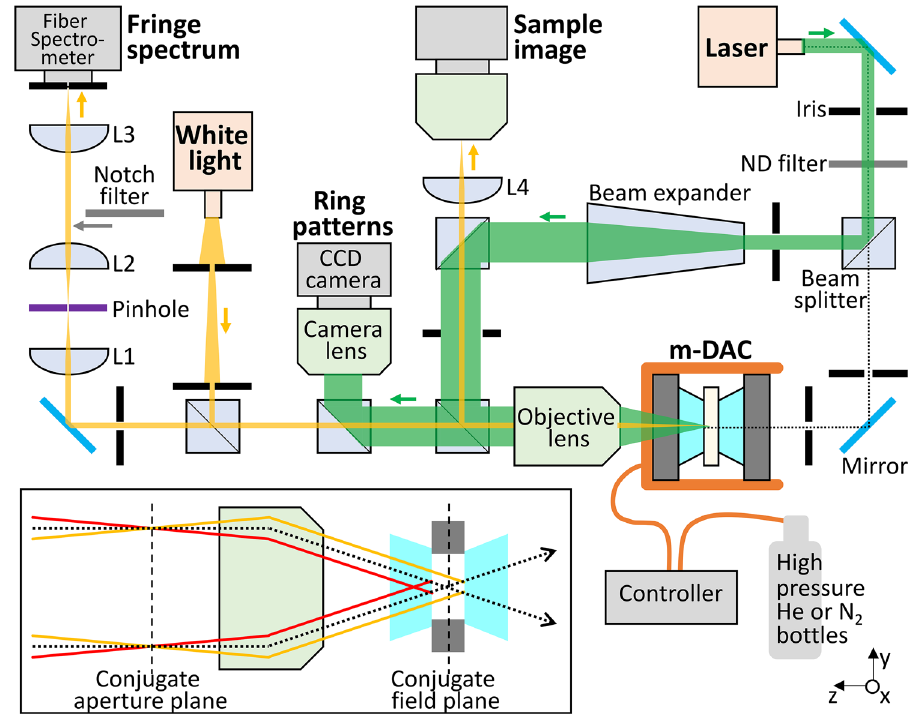
Figure 2. Schematic of our experimental setup. Interference fringe spectrum and ring pattern are obtained from the sample in the DAC with white (yellow) and laser (green) beams, respectively. Arrows indicate the direction of beam propagation from light sources to the sample through the objective lens and to the camera or the spectrometer. We also use a laser to align the tilt and rotation angles of the DAC (black dotted). The focal lengths of the achromatic doublet ( L 1 and L 2) and plano-convex ( L 3 and L 4) lenses are 50, 50, 100, and 200 mm, respectively. A 300 µm diameter pinhole is at the focus of L 1. Bottom left inset shows the focuses of a parallel incident beam (black dotted) and two reflected beams (red and yellow) at the conjugate focal planes (black